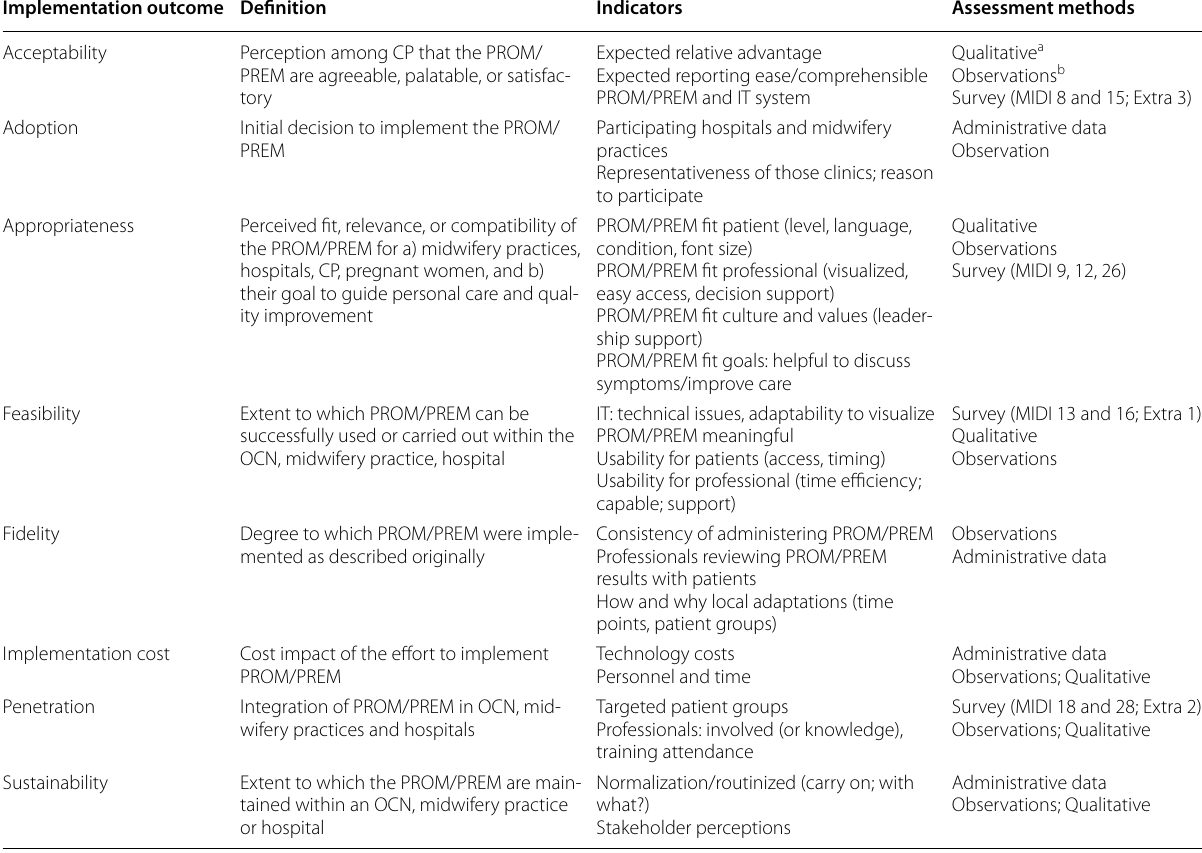
Table 1 Implementation outcomes and their